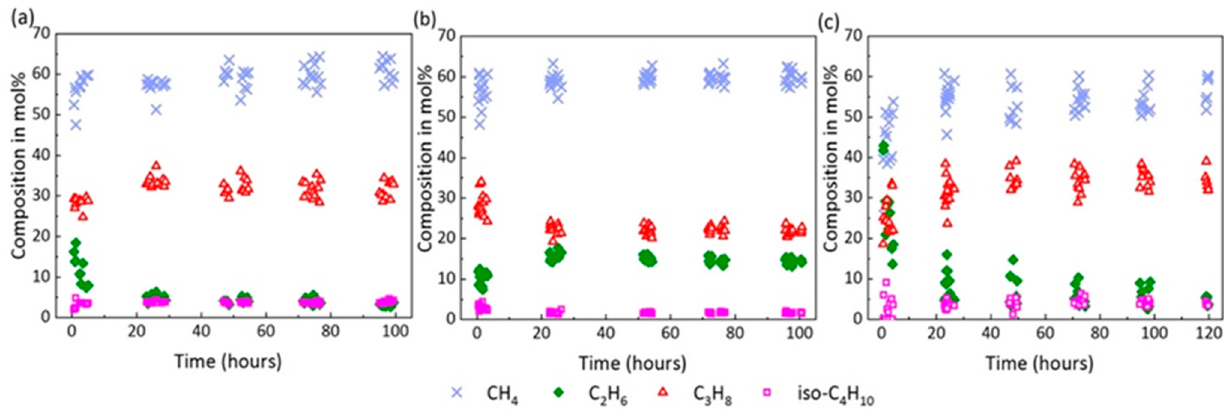
Figure 4. Composition changes measured on the surface of selected mixed hydrate crystals over the formation process in the open system ( a ), the closed system ( b ), and the semi-closed system ( c ).